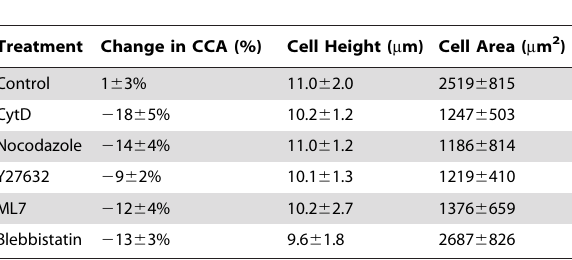
Table 1. CCA, Cell Height and Cell Area after 60 min of exposure to various